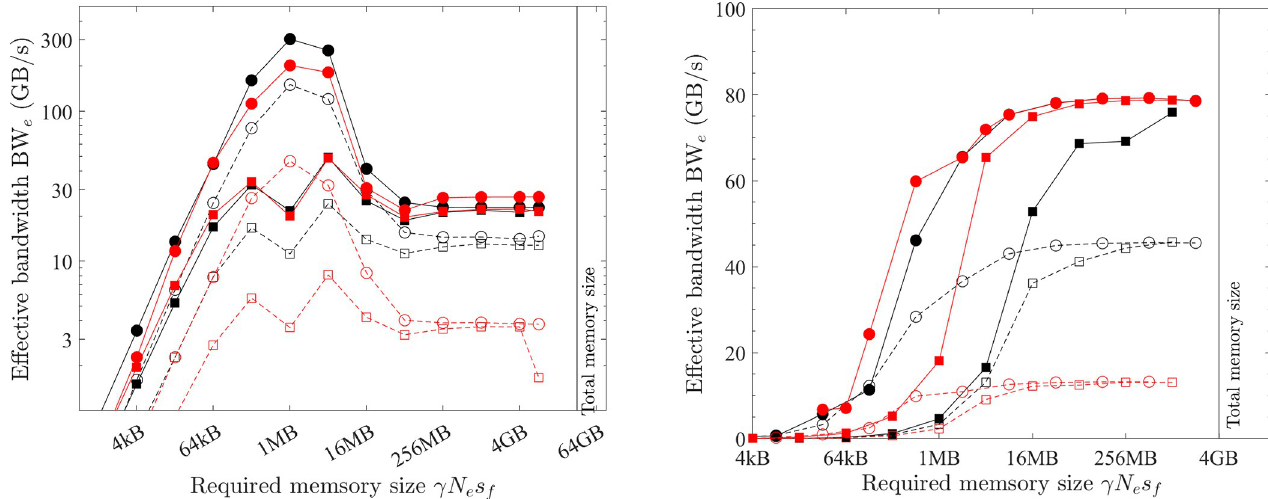
Fig 9. Fused operations (filled circles) vs. simple operations (hollow circles) and XLA (filled squares) vs. without XLA (hollow squares) (black = AXPY1D; red = XPXPY6_1D). (a) CPU platform of PC (f64). (b) GPU platform of PC (f64).